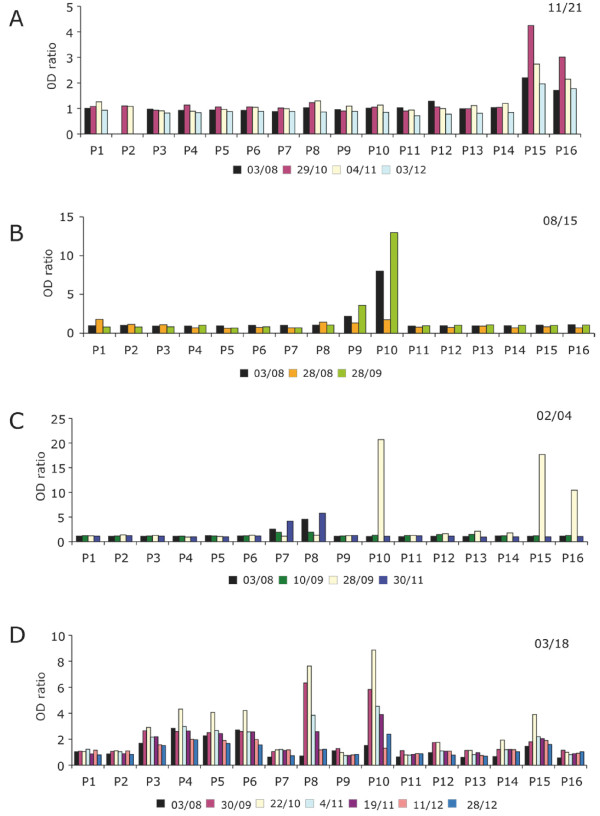
Temporal fluctuation of MSP1 block2- specific IgG during the 1998 rainy season. Antibodies were assayed on 16 pools of biotinylated peptides (sequence and composition of the pools described in Table 5). Typical individual patterns are shown, with the dates of blood sampling shown on each graph. A) Transient boosting of a pre-existing response in a 14 y old subject (code 11/21), who had a clinical malaria attack on 29/10/98. B) Transient loss of a pre-existing response in a 5 y old child (code 8/15), who had a clinical malaria attack on 28/08/98. C) Transient acquisition of a novel specificity in a 9.5 y old child (code 02/04), who had a clinical malaria on 10/09/98. D) Transient changes in a 5 y old child (code 03/18), who experienced three successive clinical episodes during that time period on 17/09/98, 22/10/98 and 11/12/98. For each cinical episode, an antimalarial treatment was administered to the patient on the day of diagnosis.